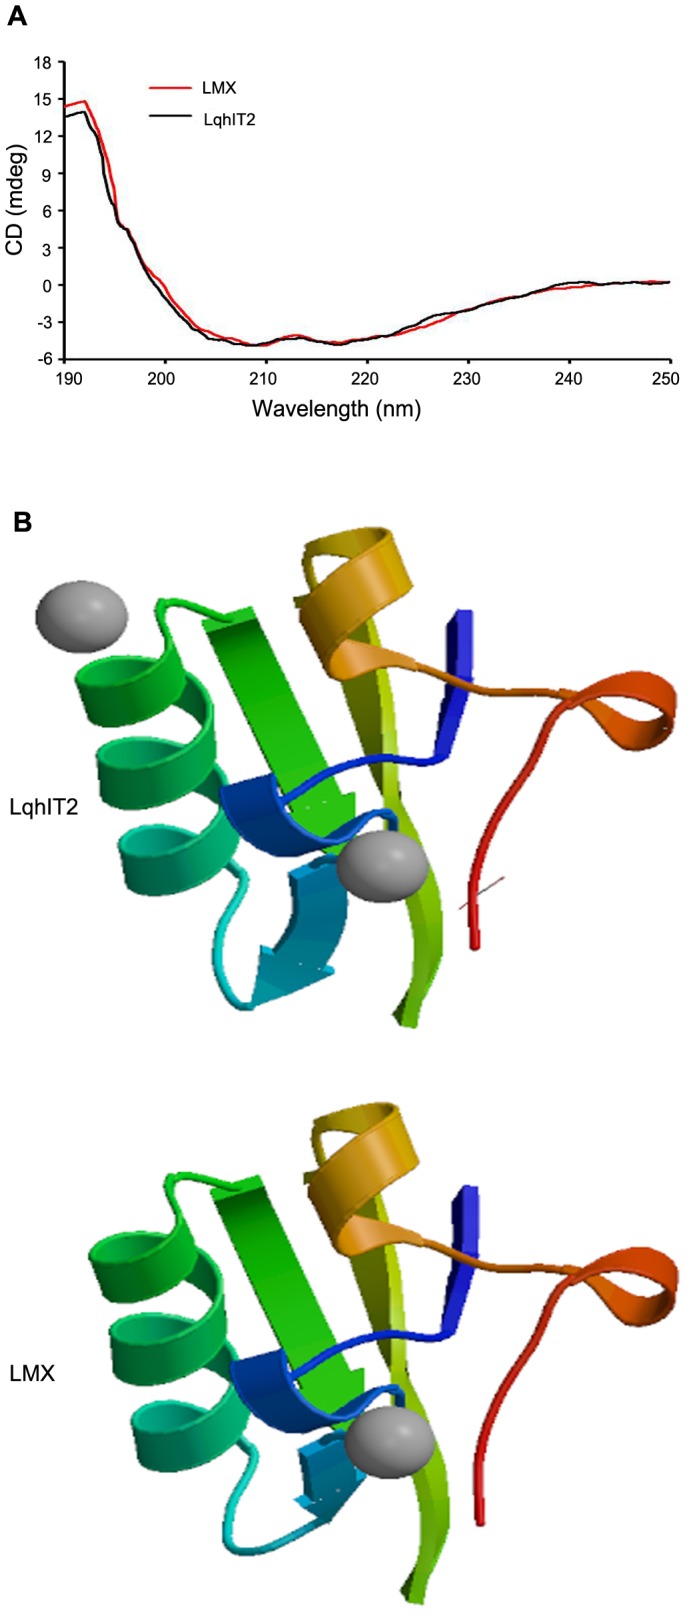
Structural analysis of LMX and LqhIT2 protein.
A. Comparison of the secondary structure of LMX and LqhIT2 protein by CD spectra. B. The homologous modeling of LMX was performed by SWISS-MODEL. The homologous modeling used the three-dimensional structure of LqhIT2 as a template.